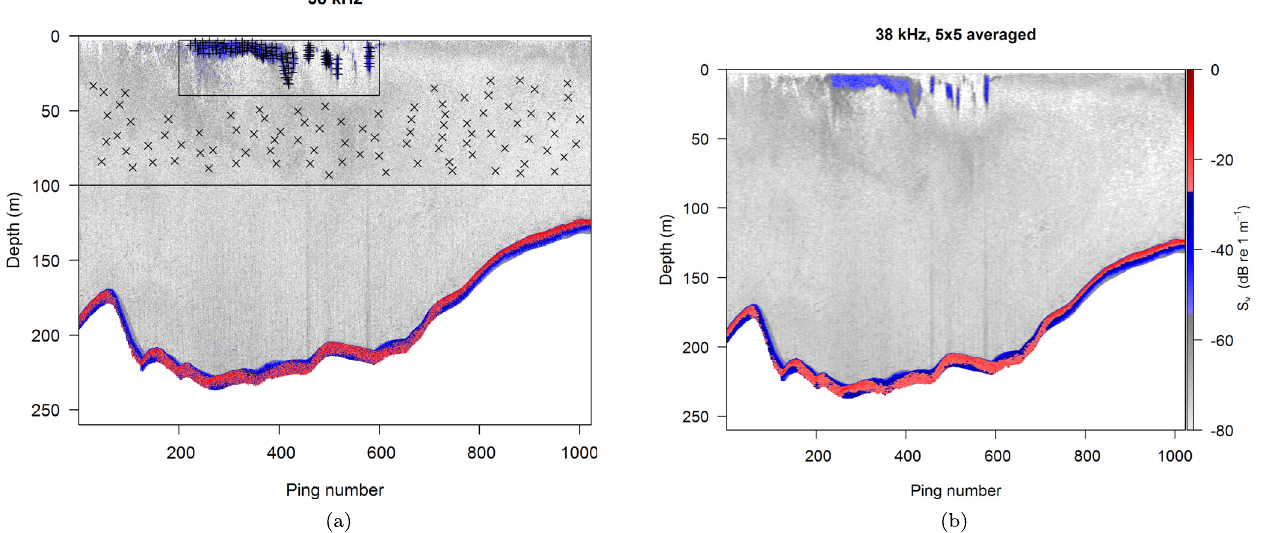
Fig. 1. (a) Raw S v echogram associated to haul no. 4 for which the EM algorithm was applied to three sets of data: the whole echogram excluding echoes below the sea bottom; the fi rst 100 m from the surface, delimited by the horizontal line; and the rectangular area enclosing the schools. The locations of the random samples taken from the schools ( þ ) and their surroundings ( (cid:3) ) are also represented. (b) Averaged echogram using a 5 (cid:3) 5kernel for which the EM algorithm was also applied to the same sets of data as in (a). The colour scale is the same for both